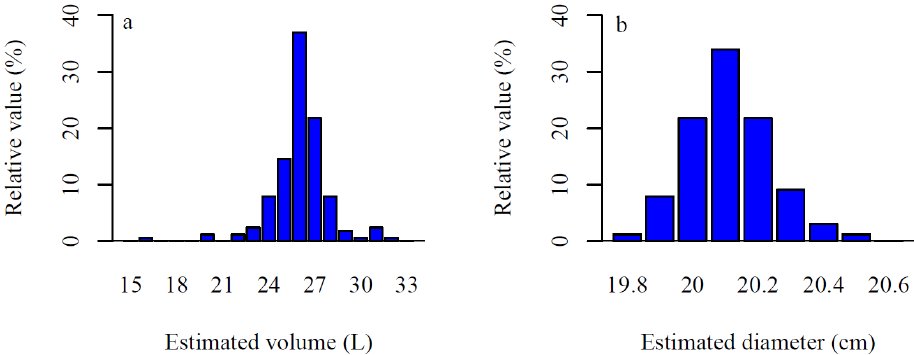
Figure 10. ( a ) Distributions of the estimated stump portion volumes (L) and ( b ) diameters (cm) for 165 model fits of stump 2.